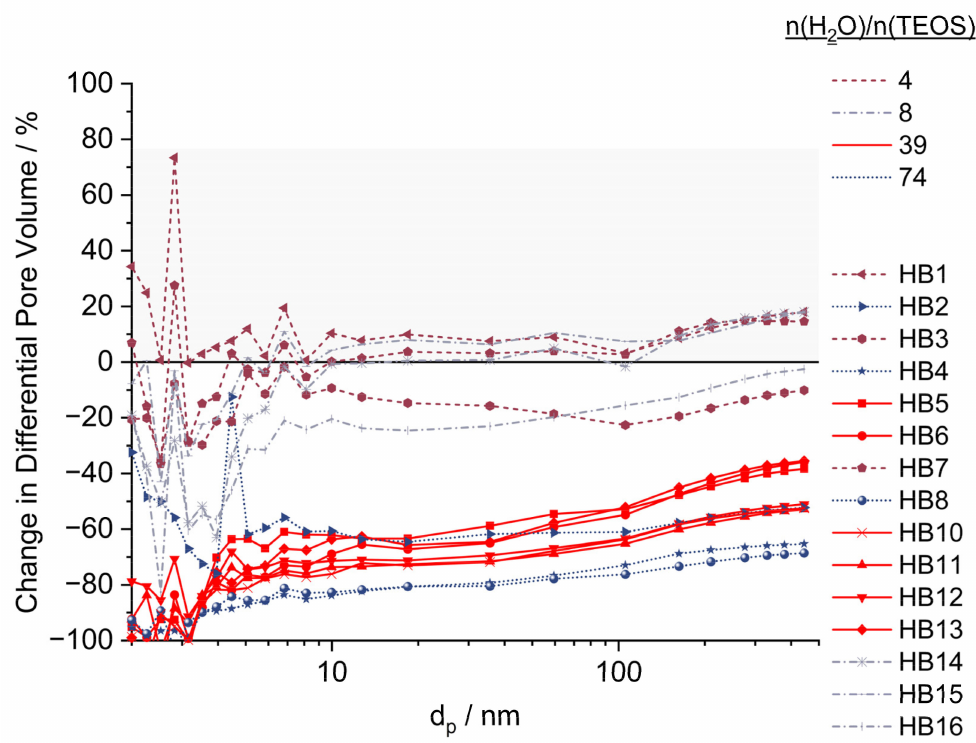
Figure 6. Relative change in pore volume distribution dependent on the pore size compared to the template particle. Line colors and types are grouped according to n(H 2 O)/n(TEOS) level setting: n(H 2 O)/n(TEOS) = 4 as burgundy dashed line, n/n = 8 as grey dashed-dotted line, n/n = 39 as solid red line and n/n = 74 as dotted blue